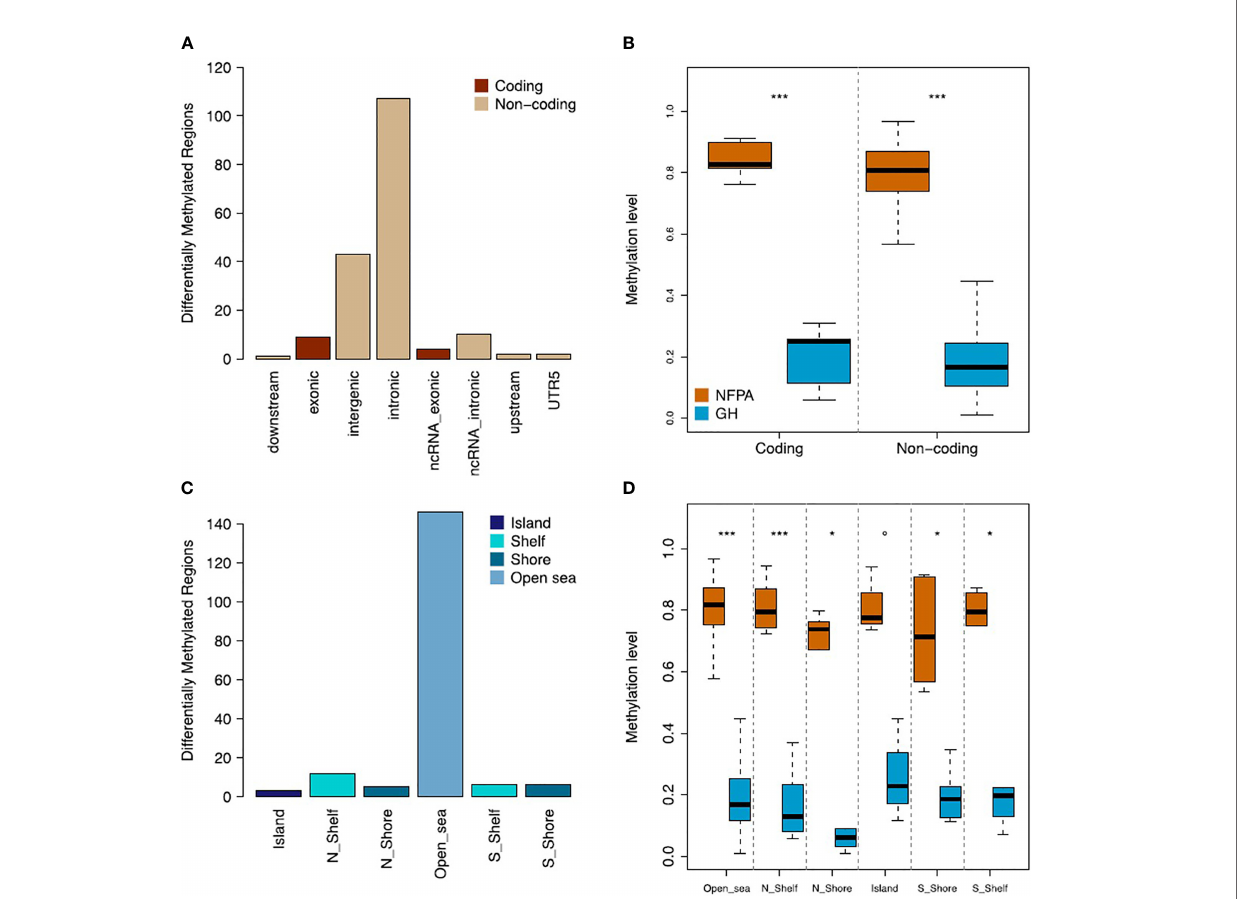
FIGURE 2 | NFPAs and GH tumors are differentially methylated. (A) Barplot showing the gene annotation of the 178 DMRs. (B) Boxplot reporting the comparison of methylation levels of coding and noncoding regions between nonfunctioning pituitary adenomas (NFPAs) and GH tumors. (C) Barplot showing the CpG-related annotation of the 178 DMRs. (D) Boxplot reporting the comparison of methylation levels of CpG-related regions between NFPAs and GH tumors. Mann – Whitney test was used in (B, D) P = 0.1 (°), P < 0.01 (*), P < 0.0001